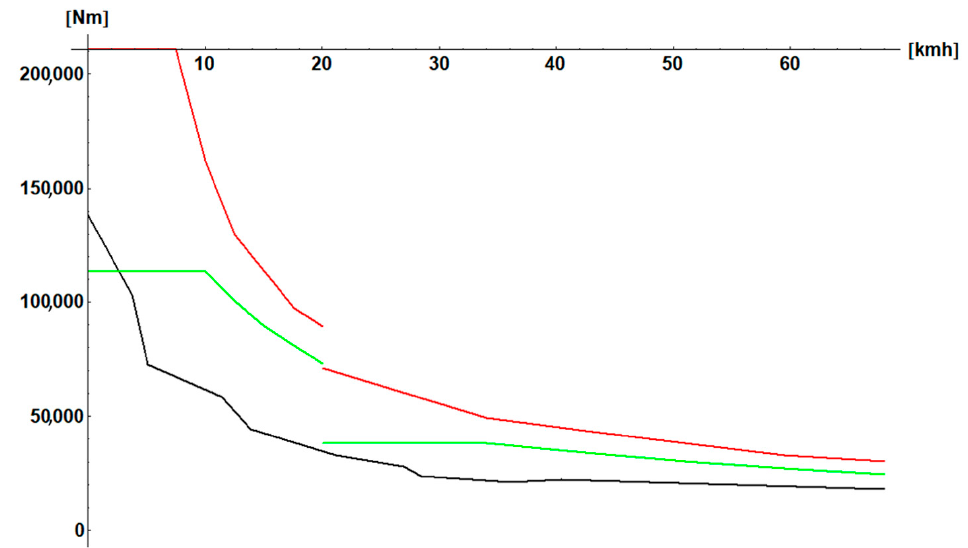
Figure 11. SHEV continuous torque available at sprocket compared with a traditional ICE-MBT (black curve). The red line is the instantaneous torque from the SHEV motors.